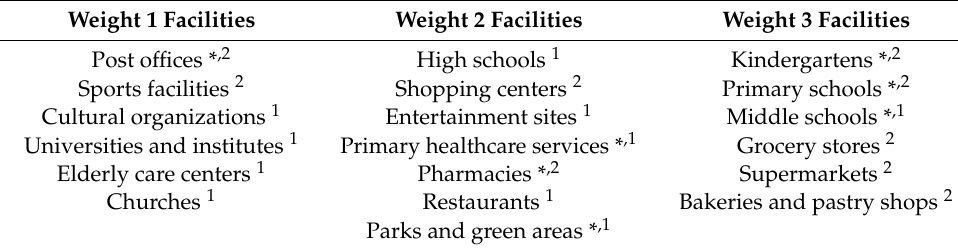
Table 1. Facility types and jobs